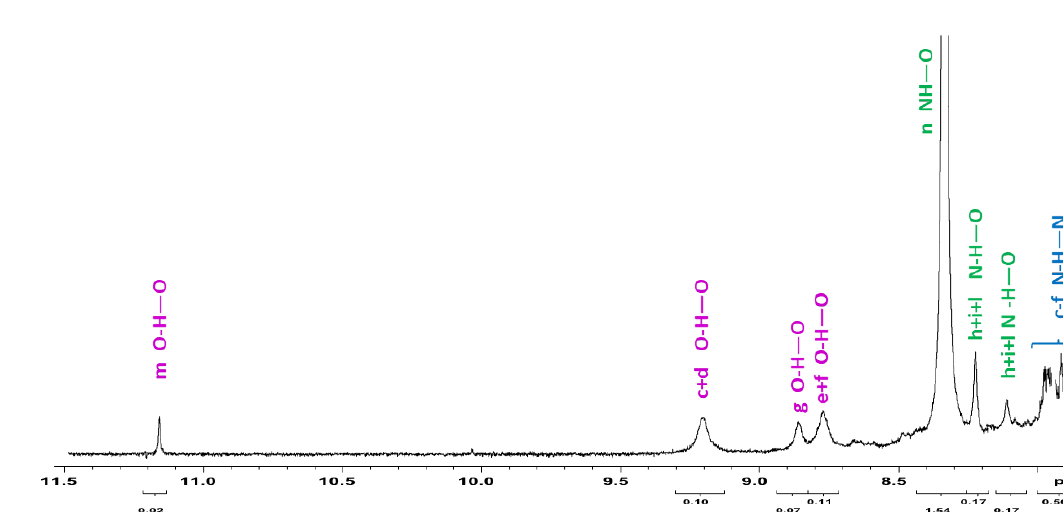
Figure 5. 1 H spectra relative to ( 3 + 4 ) mixture showing the intermediate trapping during the reaction course. The integrals evaluation for the tautomeric ratio results to be 1:3.2 with the prevalence of the stable amido conformation. The attributions of the H-bond functions of the type X–H–O (X=N, O) have been assigned based on the shielding effect ( δ ) O–H–O (11) < N–H–O (10-8) < N–H–N (8), related to the calculated DFT energy scale of the dimers sketched in Scheme 8.